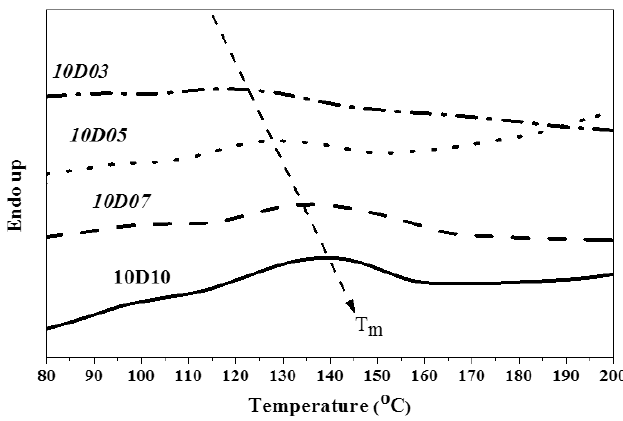
Figure 13. DSC curve of TPU with end-capping agent at concentration of 5.0 phm.